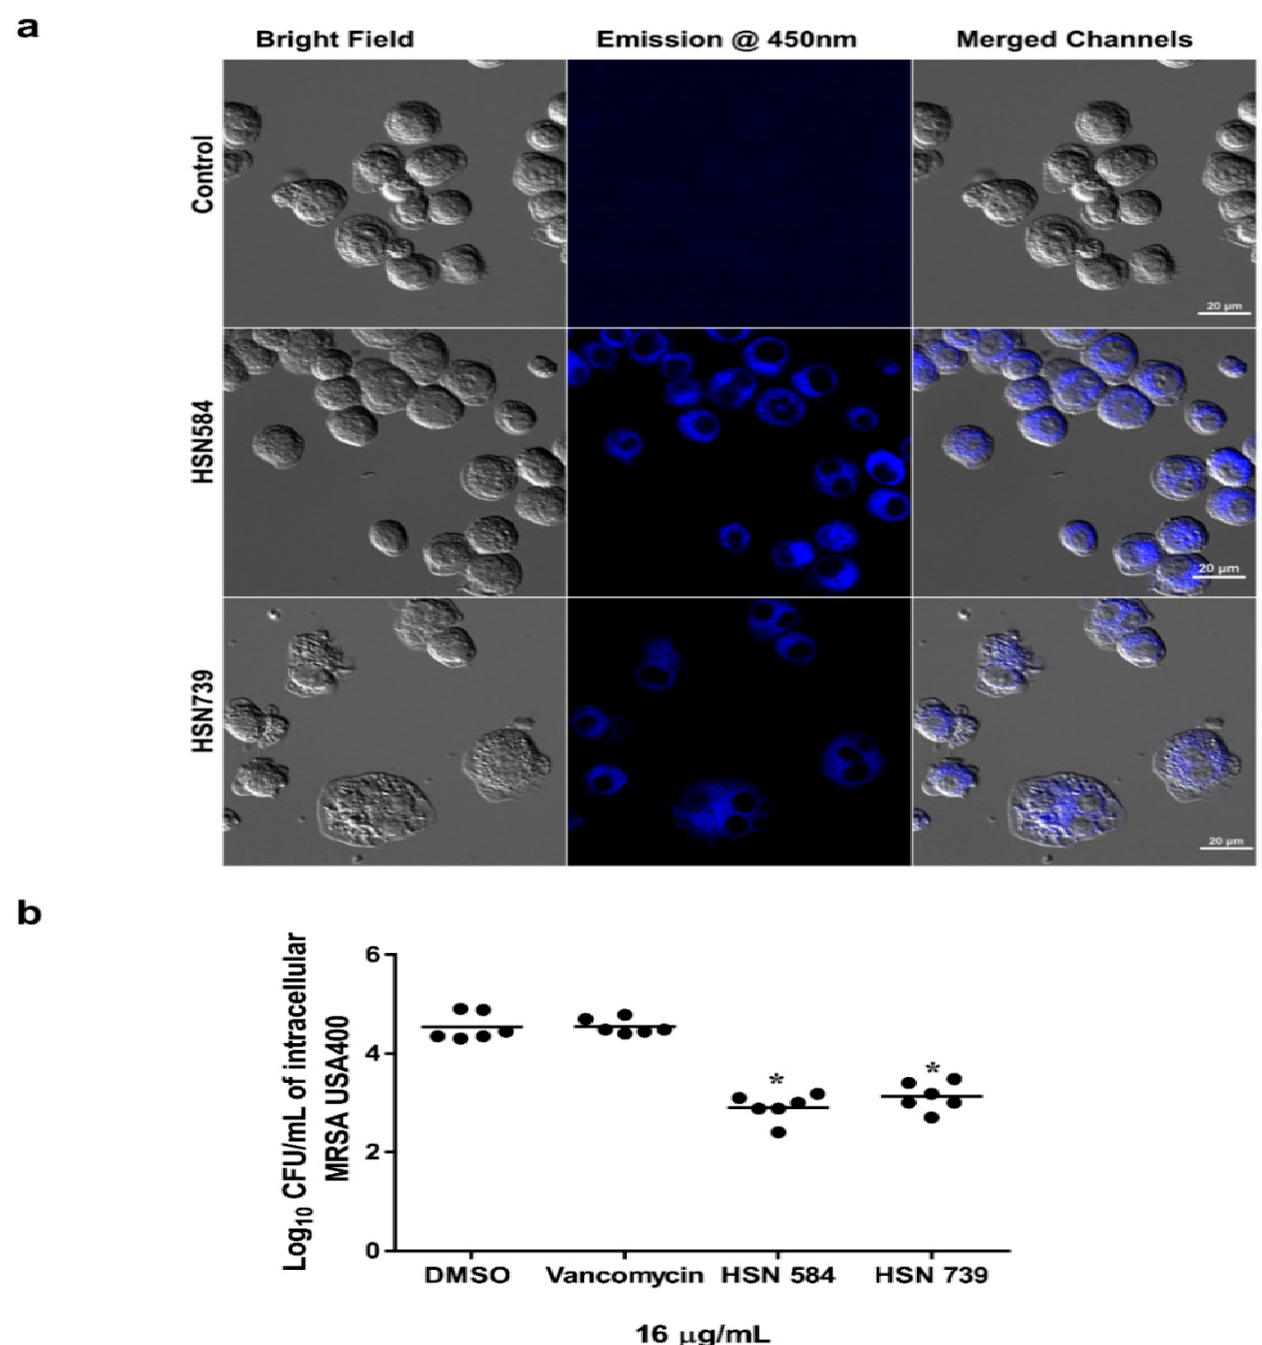
Figure 6. Alkynyl isoquinoline intracellular clearance activity. ( a ) HSN584 and HSN739 permeate murine macrophage cells and localize in the cytoplasm. ( b ) HSN584 and HSN739 significantly reduce MRSA USA400 load in murine macrophage cells after treatment with 16 µg/mL of either drug for 24 h. Data analysis performed with one-way ANOVA with post hoc Dunnett’s test for multiple comparisons. * = p -value < 0.05.